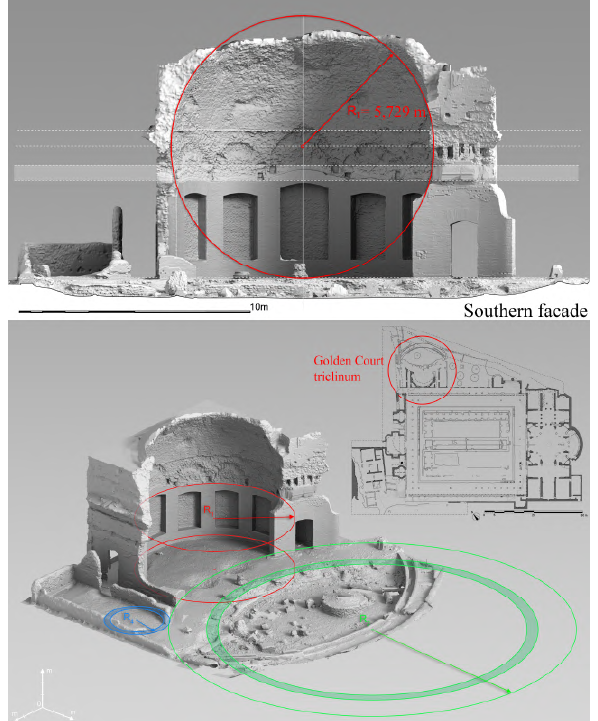
Figure 12. Triclinium of the Golden Court.